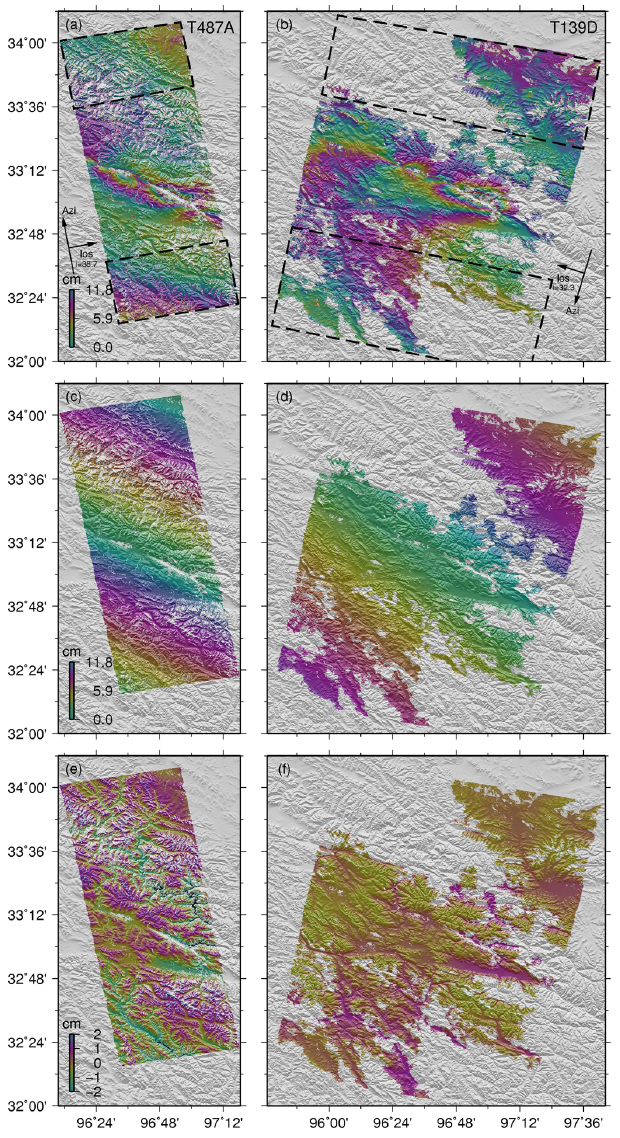
Fig. 2. The ascending track 487 strip mode (a) and descending track 139 wide-swath mode (b) raw interferograms, corrections from or- bital errors ( c and d ), and corrections from a linear tropospheric delay related to topography ( e and f ). The data in dashed region are used for correction parameters estimation.